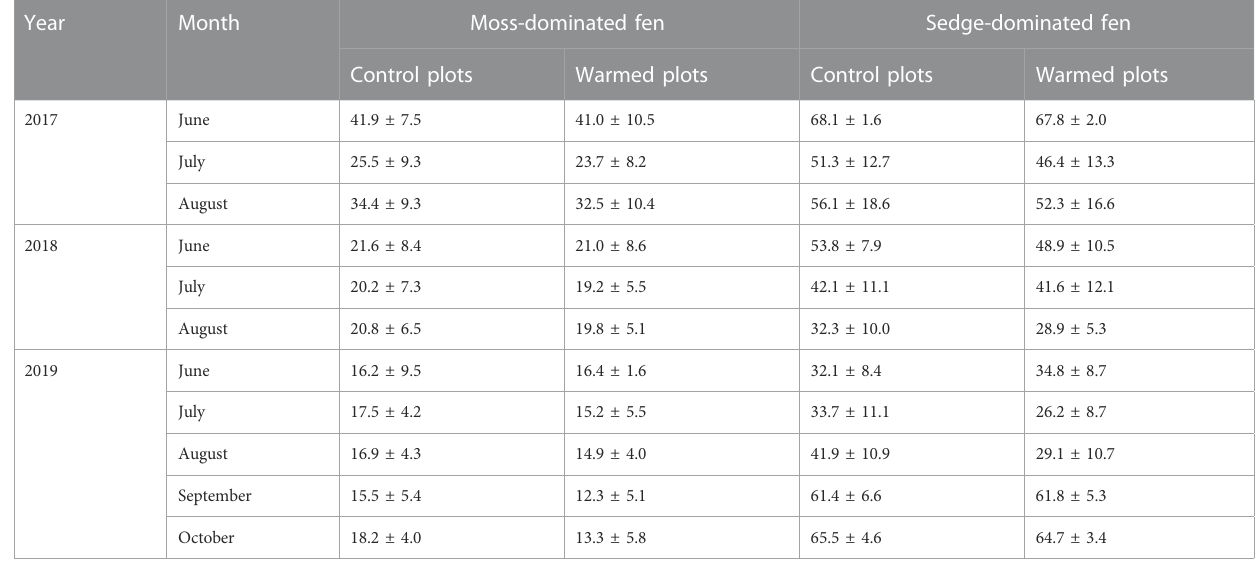
TABLE 1 Average monthly soil moisture (± standard deviation; % v/v) in the control and warmed plots in the moss-dominated fen and the sedge-dominated fen over the